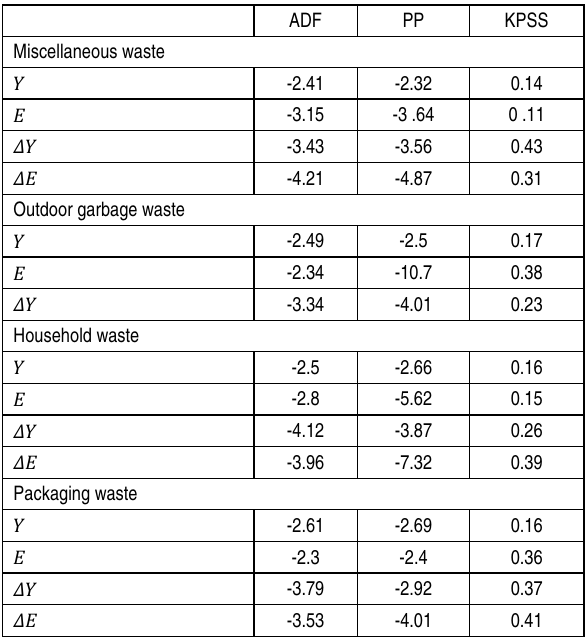
Table 2. Unit root tests ADF KPSS